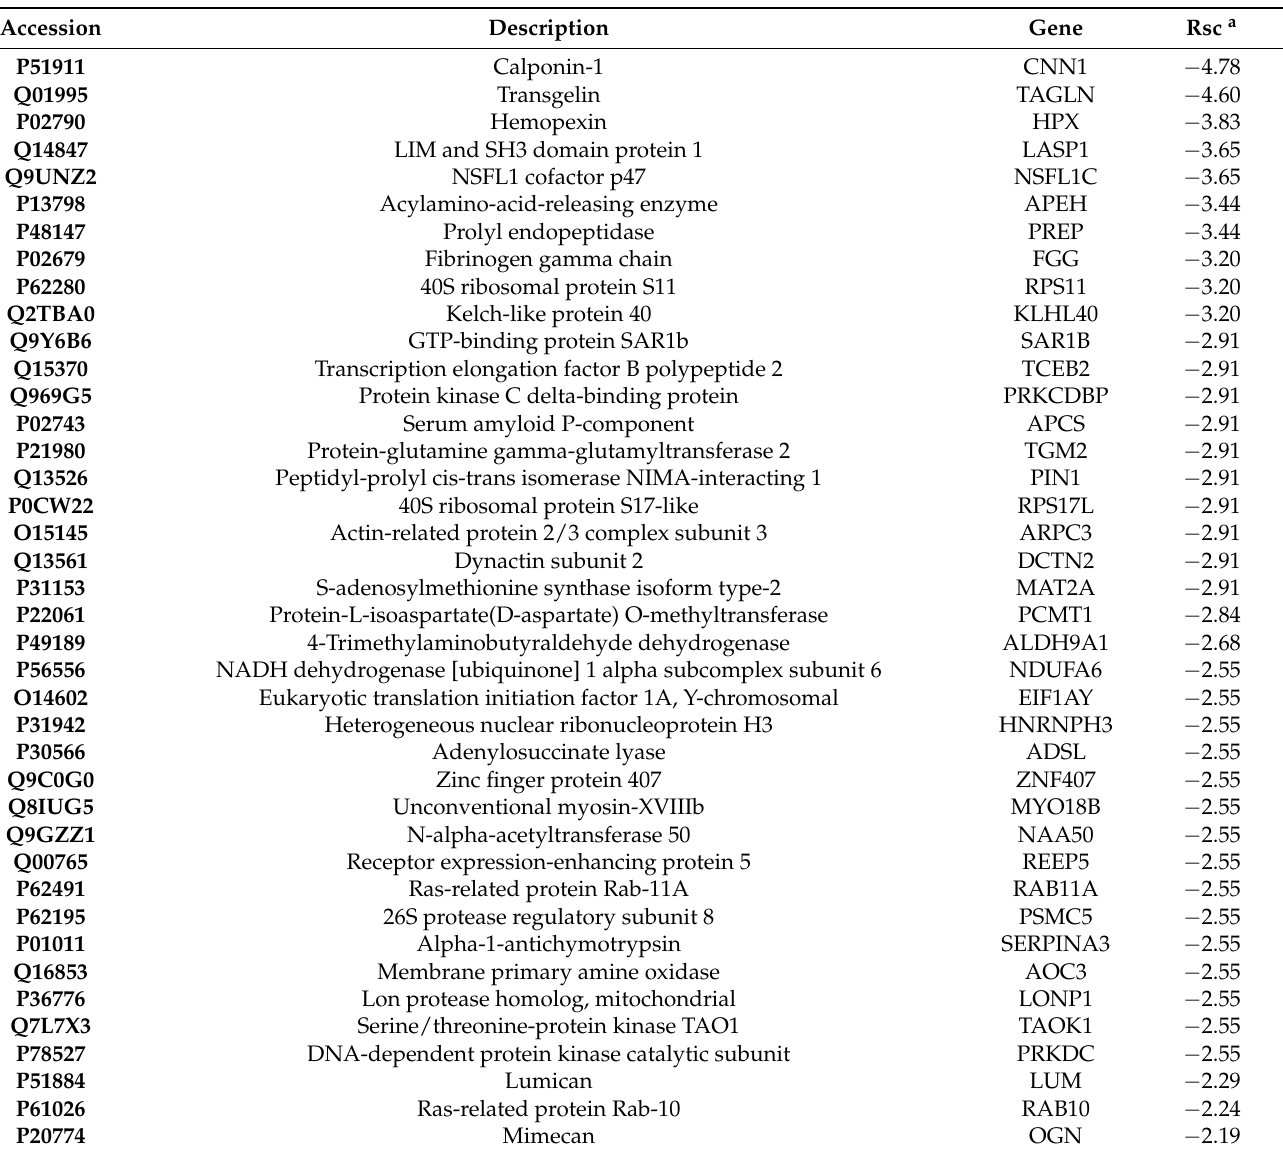
Table 3. Label-free quantitative analysis of proteins identified from V. lateralis muscle